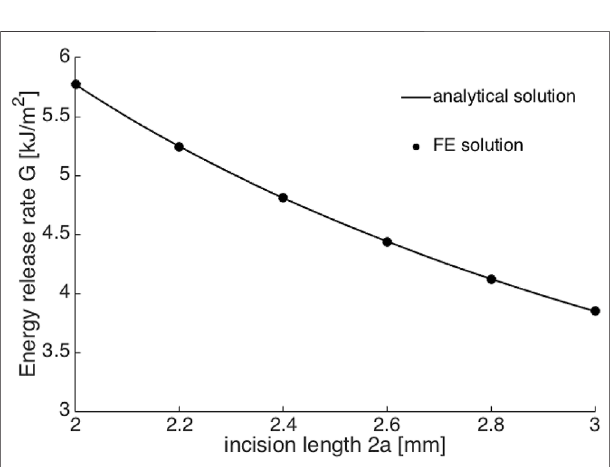
FIGURE 6 | The comparison between FE numerical solutions (black dots) and analytical solutions (black line).